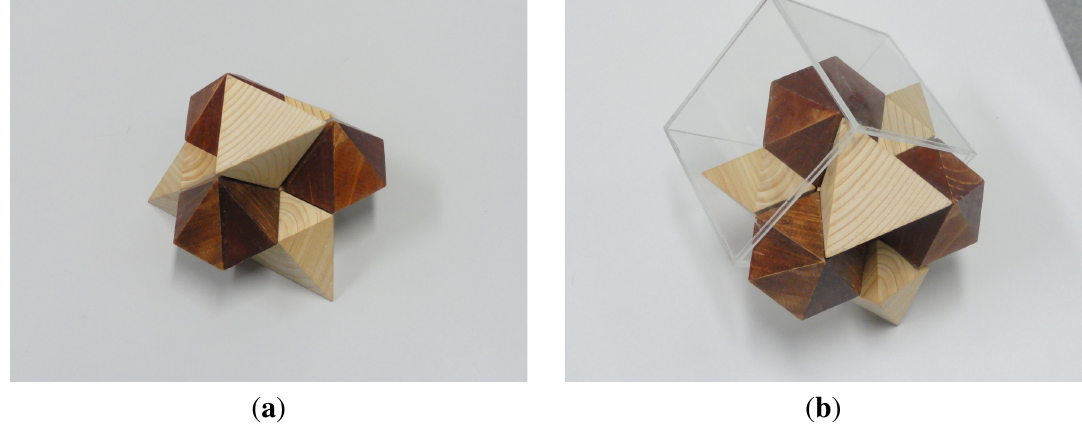
Figure 13. V-vertices of the three dimensional tiling with H and T with T